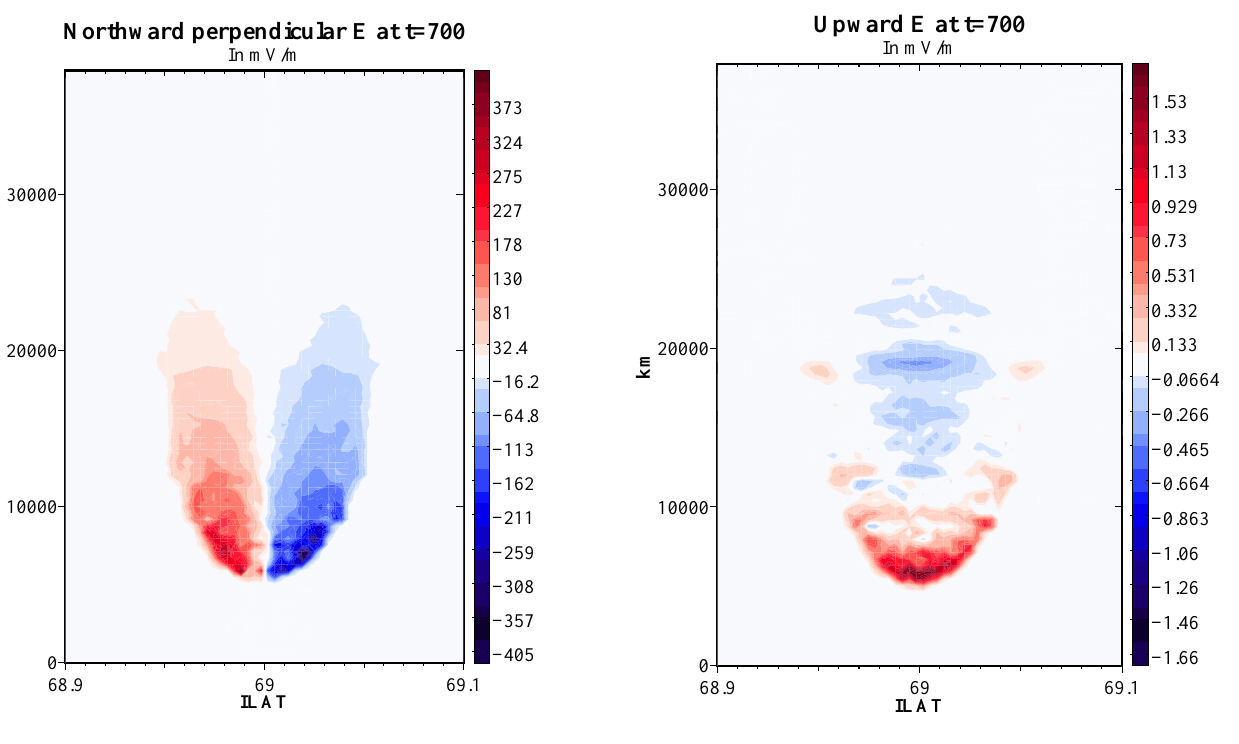
Fig. 8. Parallel (positive upward) electric field at t =